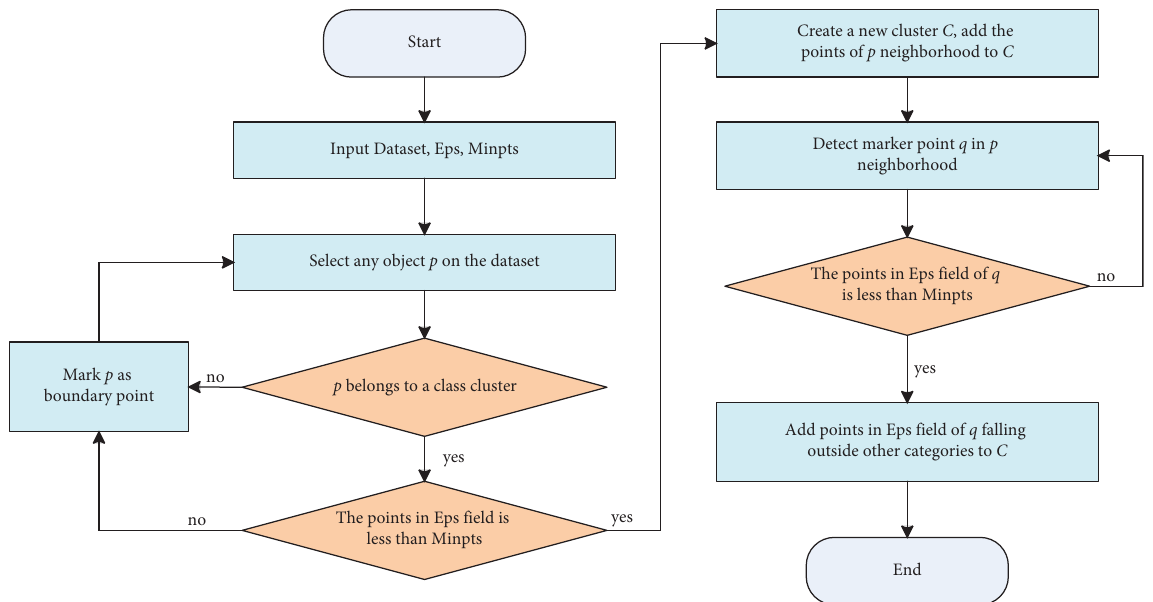
Figure 1: Flowchart of the DBSCAN clustering algorithm.